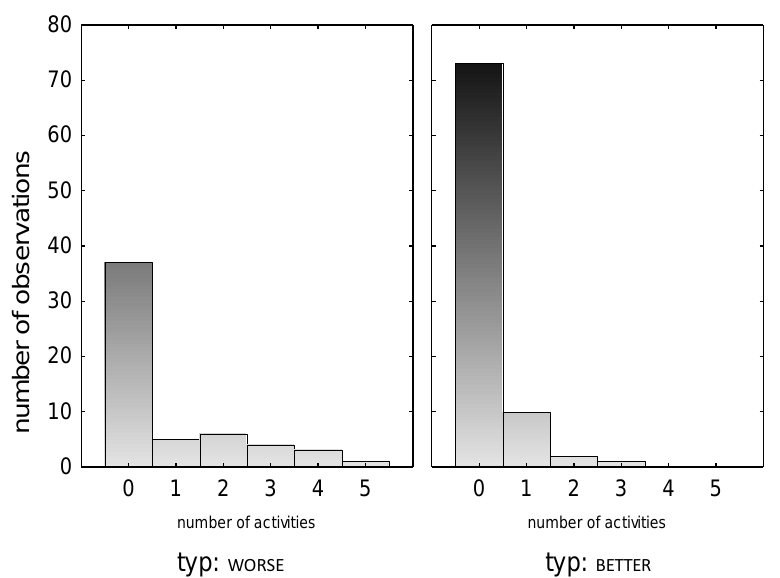
Figure 5. Histograms for the number of participatory activities attended by respondents in both groups under study.